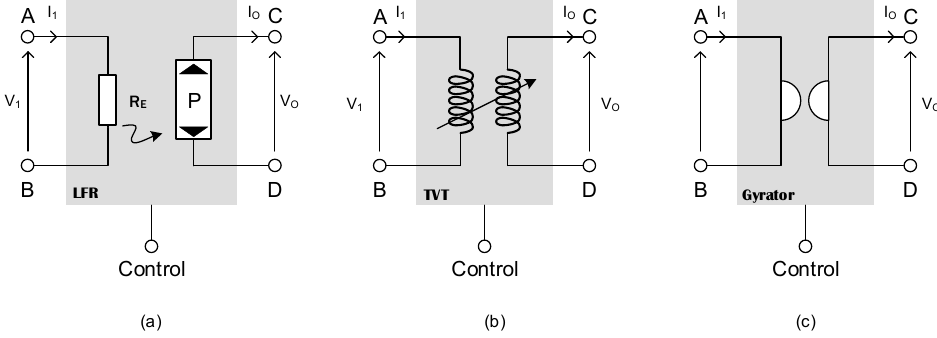
Figure 5. Typical models of POPI networks. ( a ) Loss-free resistor (LFR); ( b ) time-varying transformer (TVT); ( c ) gyrator.